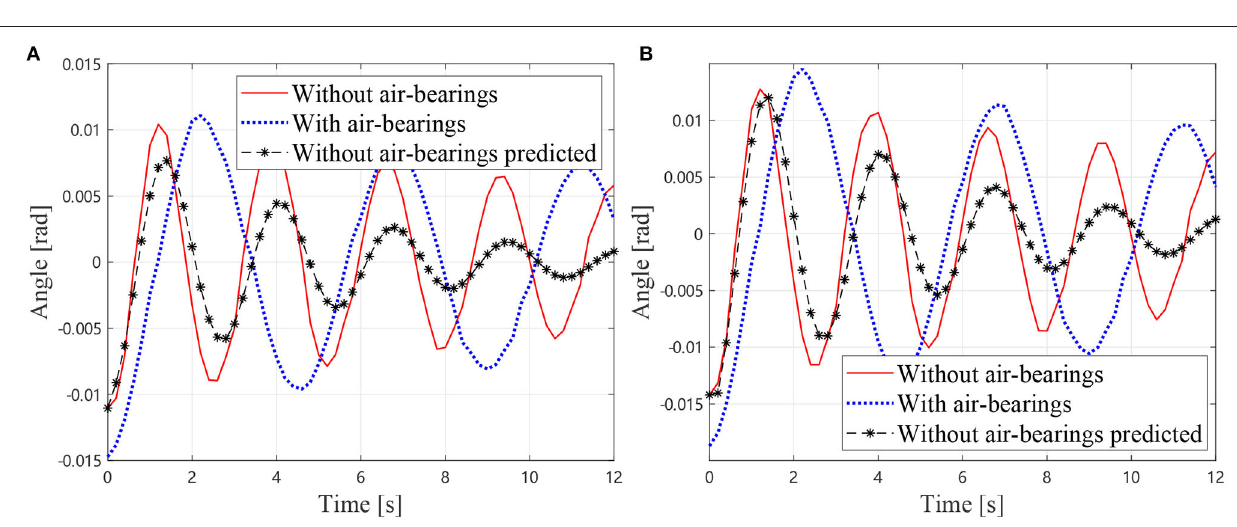
FIGURE 11 | Experimental vibration angles without air bearings (A) Angles of J 1 (B) Angles of J 2